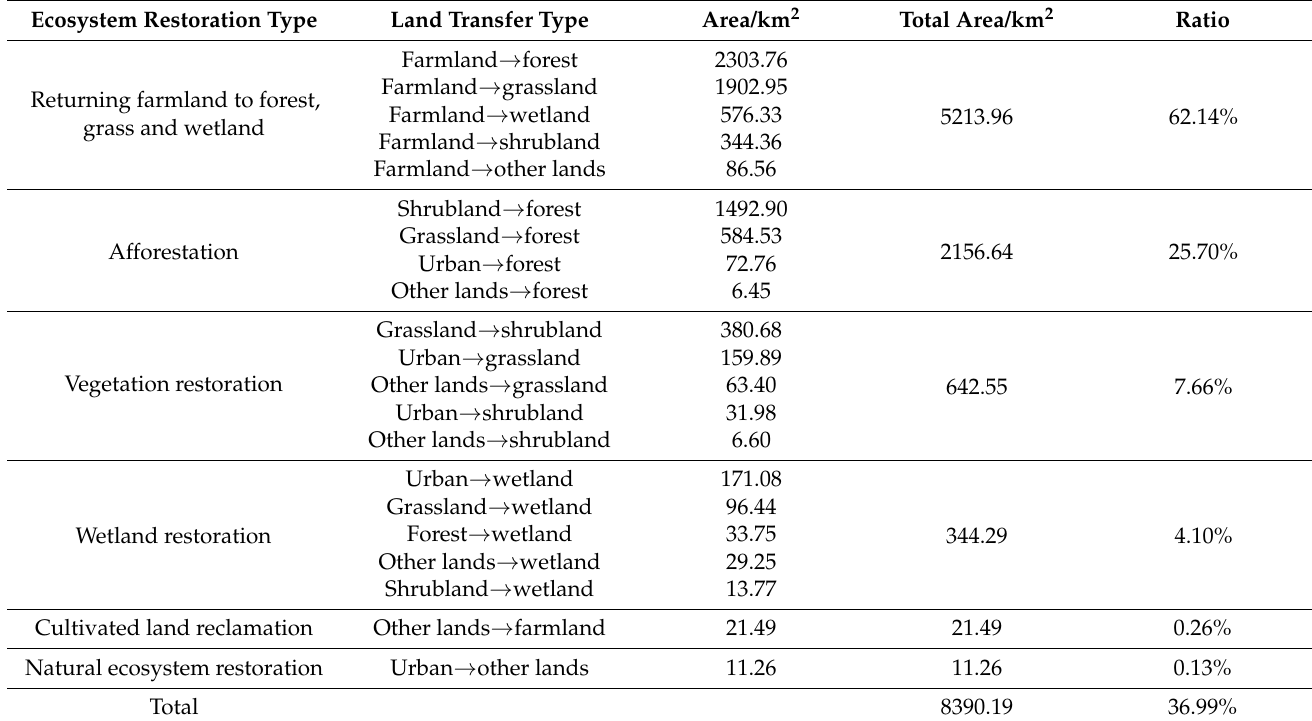
Table 3. Ecosystem restoration of the Beijing–Tianjin–Hebei urban agglomeration from 2000 to 2015.